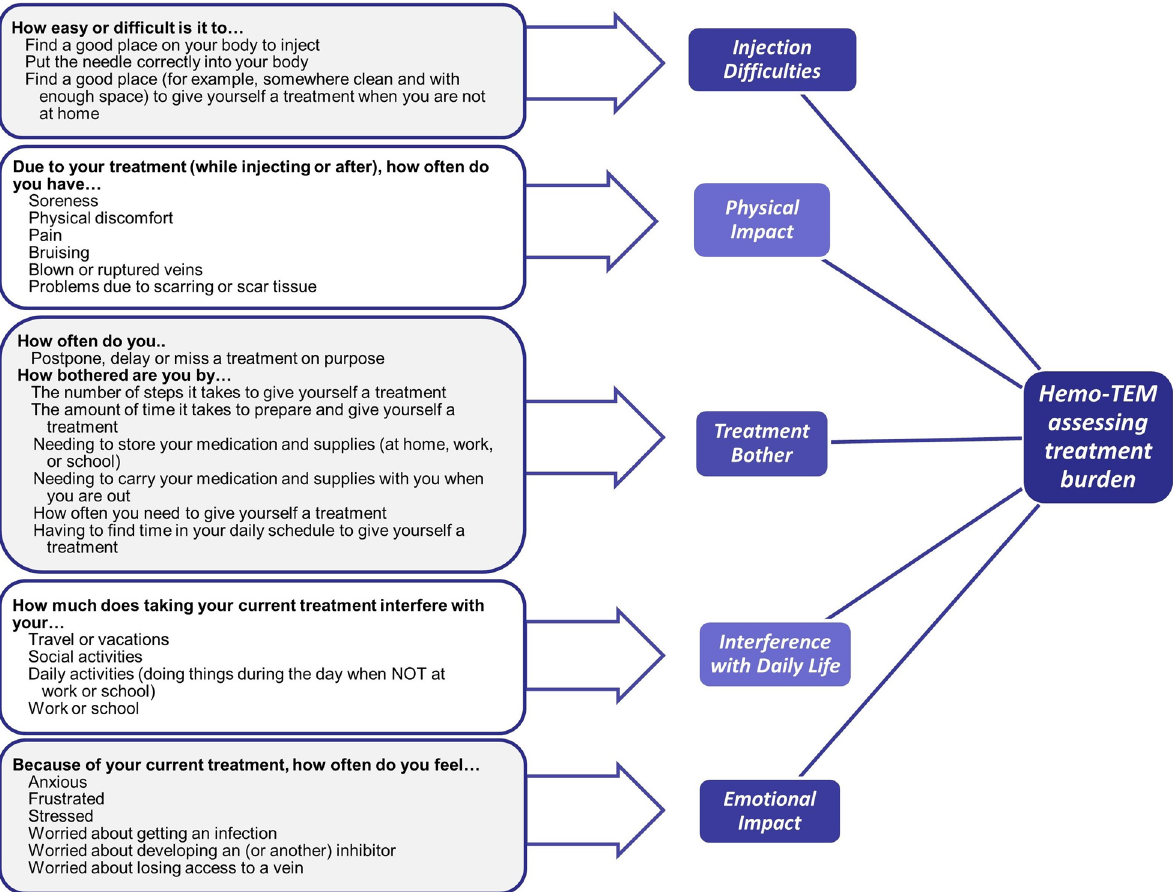
Fig. 2 Hemo-TEM Conceptual